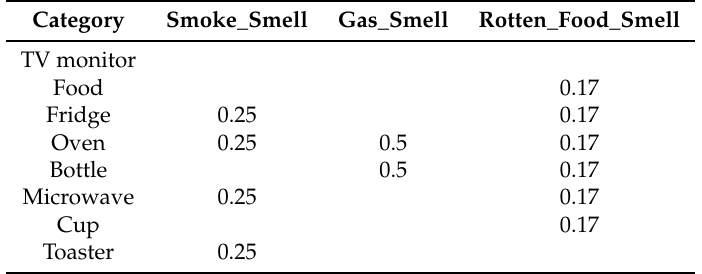
Figure 5. Categorization results for some of the objects considered in the real experiment. As can be noticed, the object recognition system is not exempt of errors, incorrectly categorizing objects in some occasions (e.g.,see storage cupboard miss-categorized as Fridge in the central picture). Table 2. Conditional source probabilities for each combination of object category and gas class: P ( S = o i | C j , G k ) . As can be seen, some categories do not release any of the gas classes considered in the experiment, an aspect to be exploited by our system, together with the object recognition uncertainty, to locate the gas